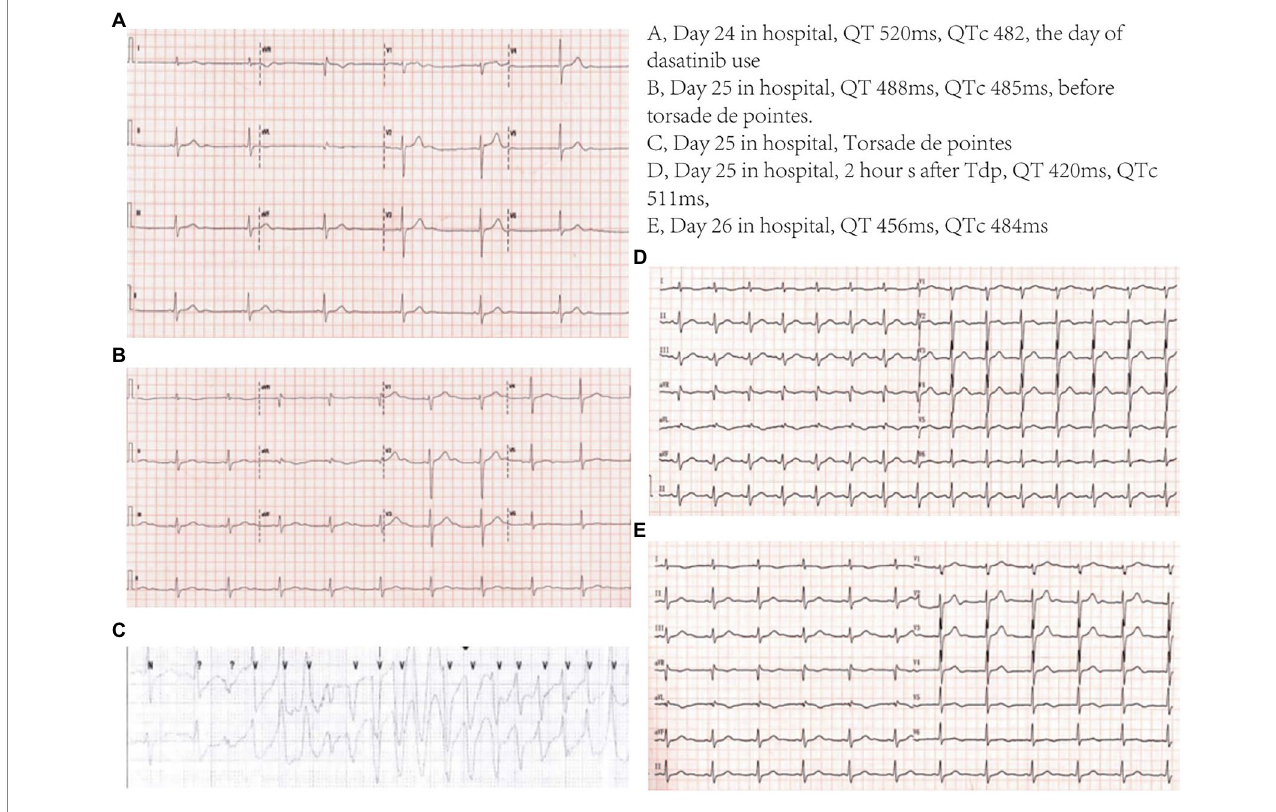
FIGURE 1 Electrocardiogram.